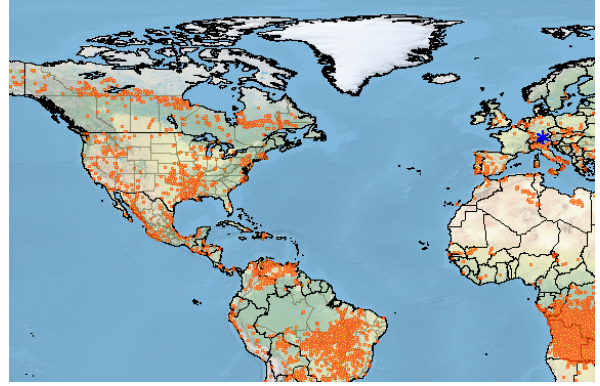
Figure 1. Fire spots between 1 and 7 July 2013, as generated by the FIRMS Web Fire Mapper: A “road of fire” formed west to east across Canada along the most frequent backward trajectory pathways initiated over Garmisch-Partenkirchen. The position of Garmisch-Partenkirchen is marked by a blue asterisk.